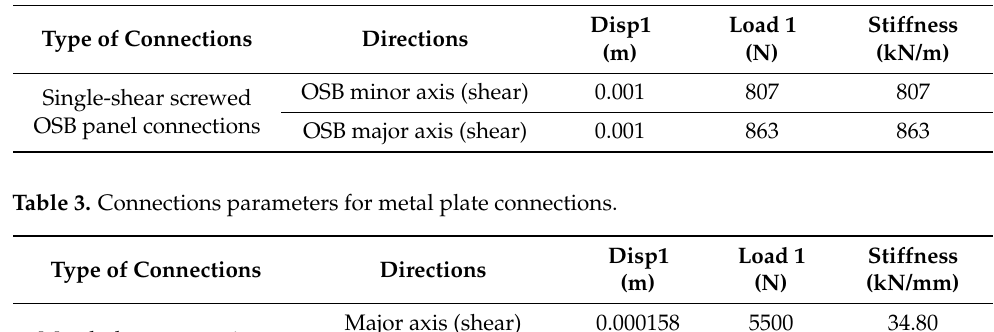
Figure 8. Numerical modeling and test results for a single wood truss joist. The elastic stiffness parameters of sheathing-to-joist connections, the calibrated elastic parameters for metal plate connections and the material mechanical parameters of the wood members were used to establish the floor models with different configurations in this study, listed in Tables 2–4, respectively. The final floor shape model with three rows of strongbacks, as an example, is shown in Figure 9. Table 2. Connections parameters for sheathing-to-joist connections.